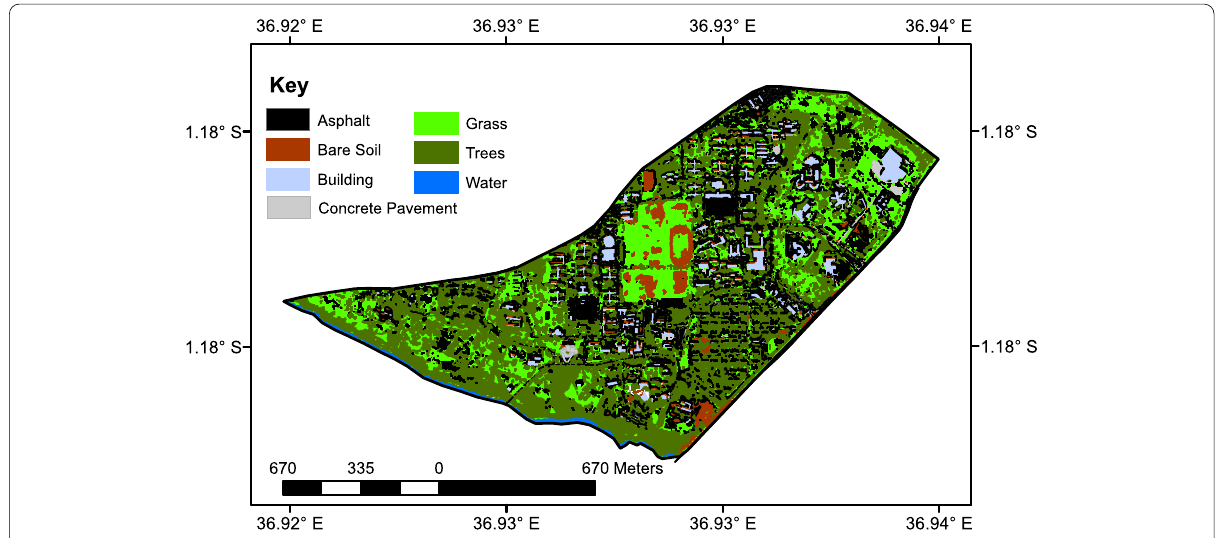
Table 6 The proportion of various land cover classes in the study area